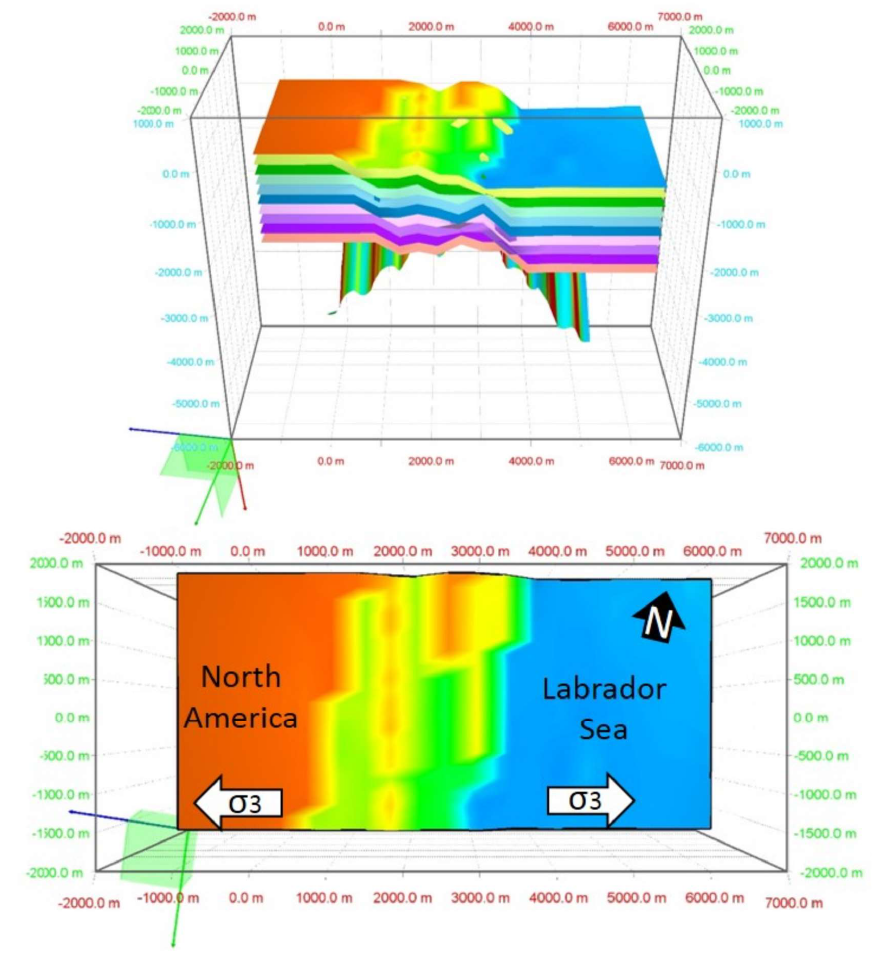
Figure 14. The semi-schematic results of the extensional analysis that was carried out in MOVE™ showing changes to topography as a result of modelled slip on fold